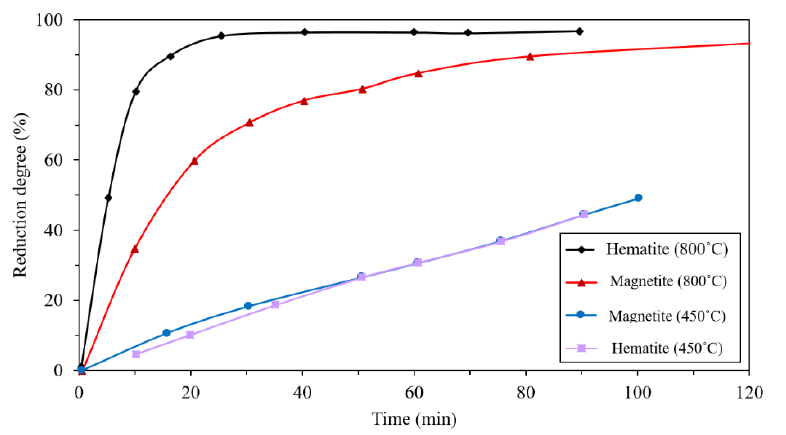
Figure 9. Comparison of hematite and magnetite reduction at the two temperatures 450 °C and 800 °C [41] “modified”.